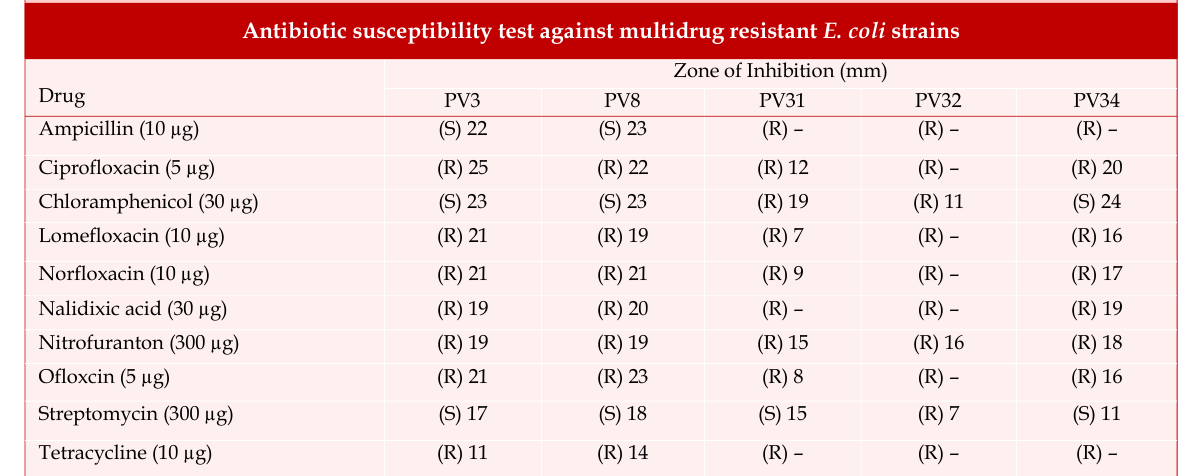
Antibiotic susceptibility test against multidrug resistant E. coli strains